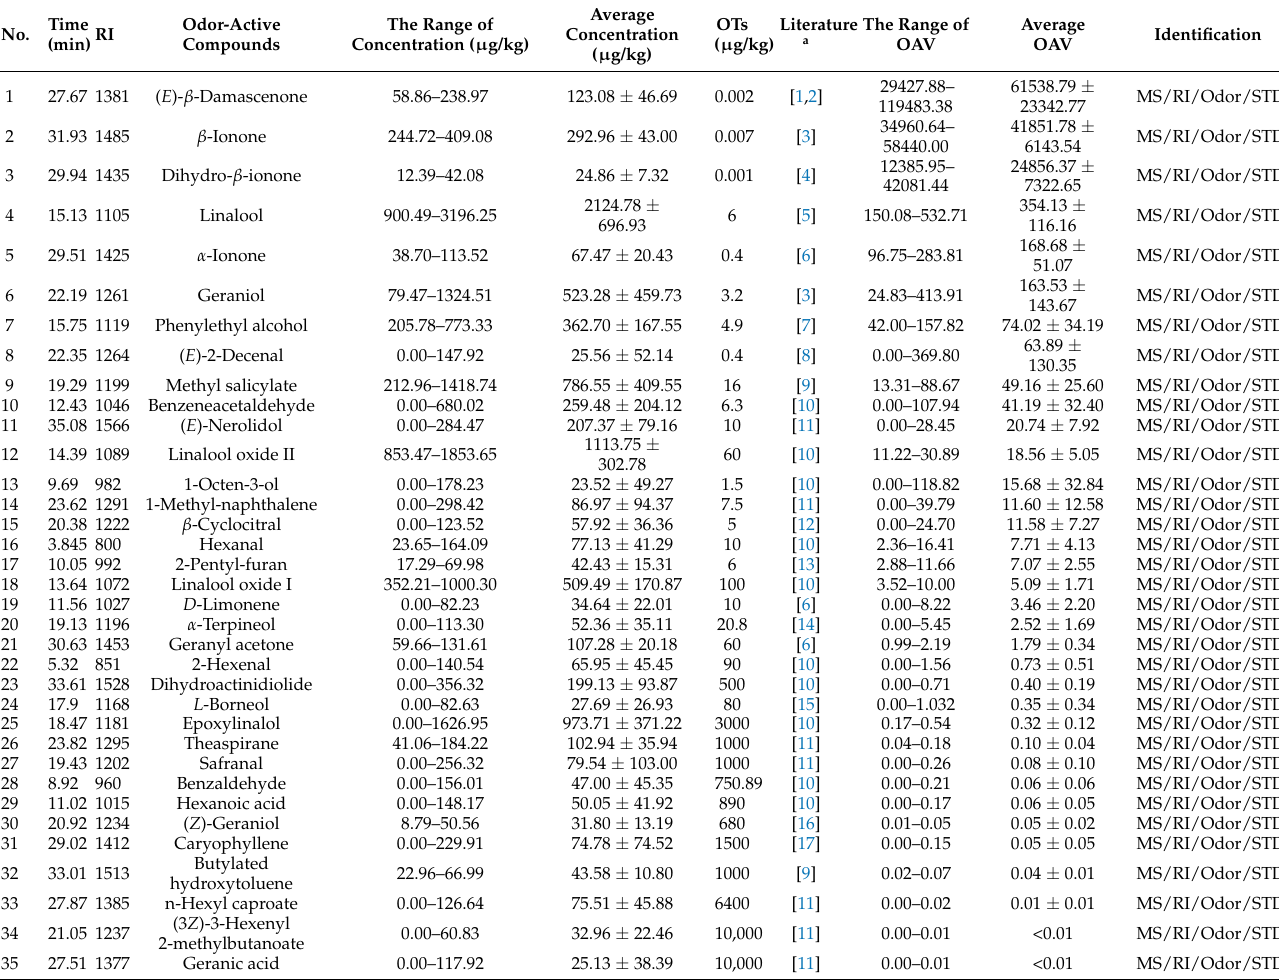
Table 2. The results of quantitative and OAVs calculation of odor-active in sun-dried black tea samples (11